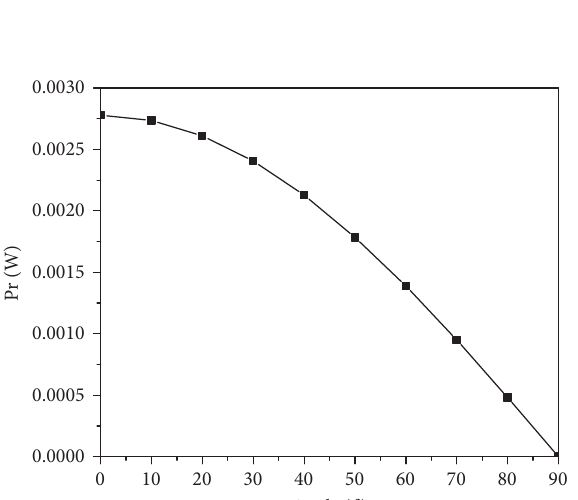
Figure 9: Visible light